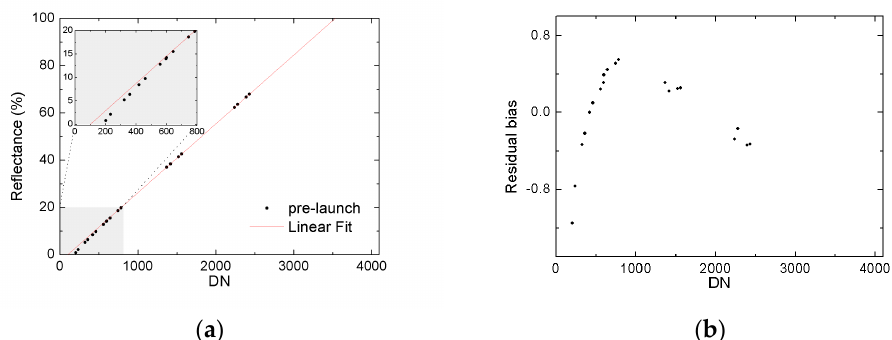
Figure 8. Pre-launch laboratory calibration measurements distribution of Band 19. ( a ) X -axis is the MERSI response digital number (DN), and Y -axis is the reference reflectance; ( b ) X -axis is the MERSI response DN, and Y -axis is the residual bias.